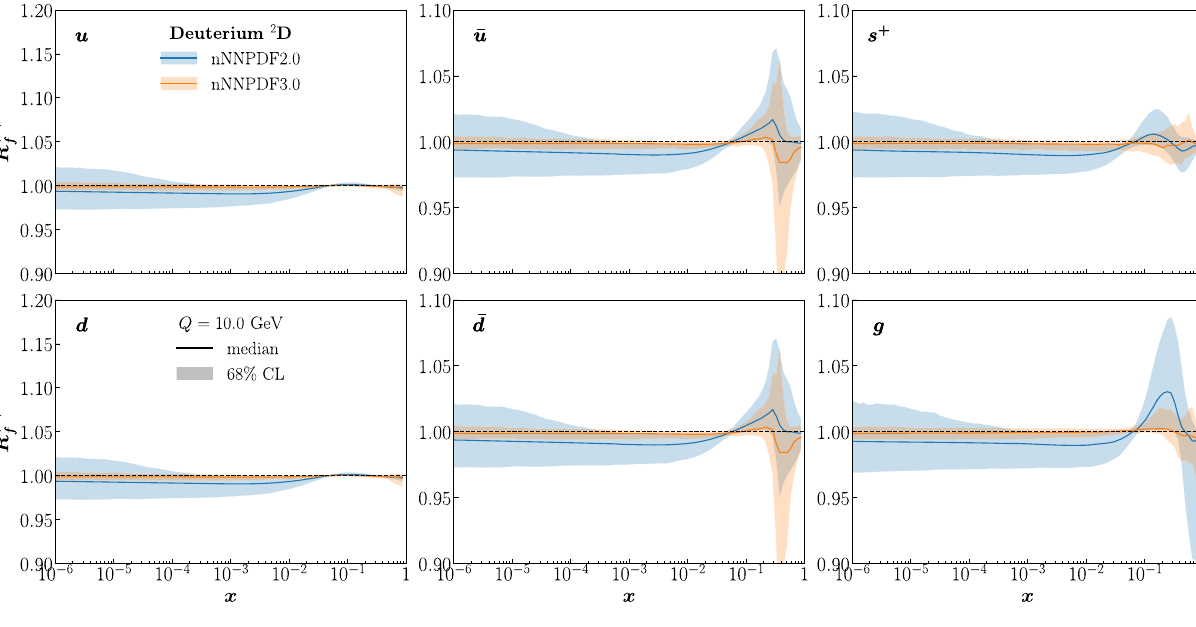
Fig. 16 The nuclear modification ratios in nNNPDF3.0 for deuterium ( A = 2) compared to